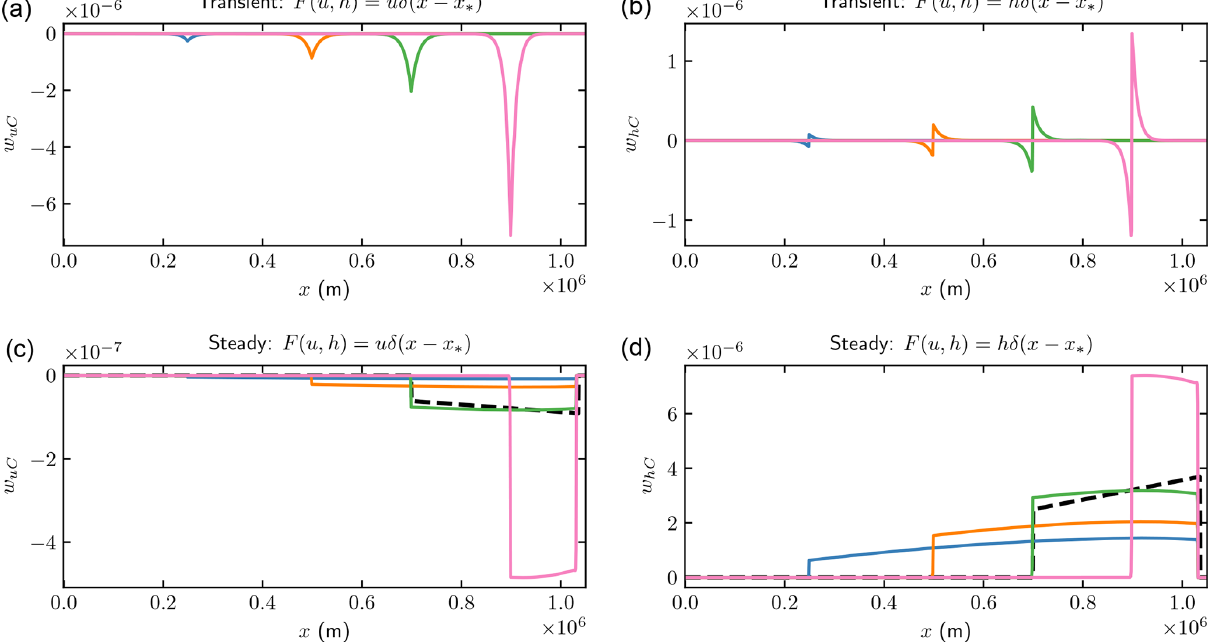
Figure 6. Comparison of the weights w uC and w hC for SSA in Eq. (19) for perturbations δC with m = 1 at different observation points x ∗ = 0 . 25 × 10 6 , 0 . 5 × 10 6 , 0 . 7 × 10 6 , and 0 . 9 × 10 6 (blue, orange, green, and pink). The dashed black lines in (c, d) are w uC and w hC computed from the analytical solutions of u in Eq. (A1) and v in Eqs. (A2) and (A4) at x ∗ = 0 . 7 × 10 6 . (a, b) Transient simulations; (c, d) steady states. (a, c) w uC for pointwise u response; (b, d) w hC for pointwise h